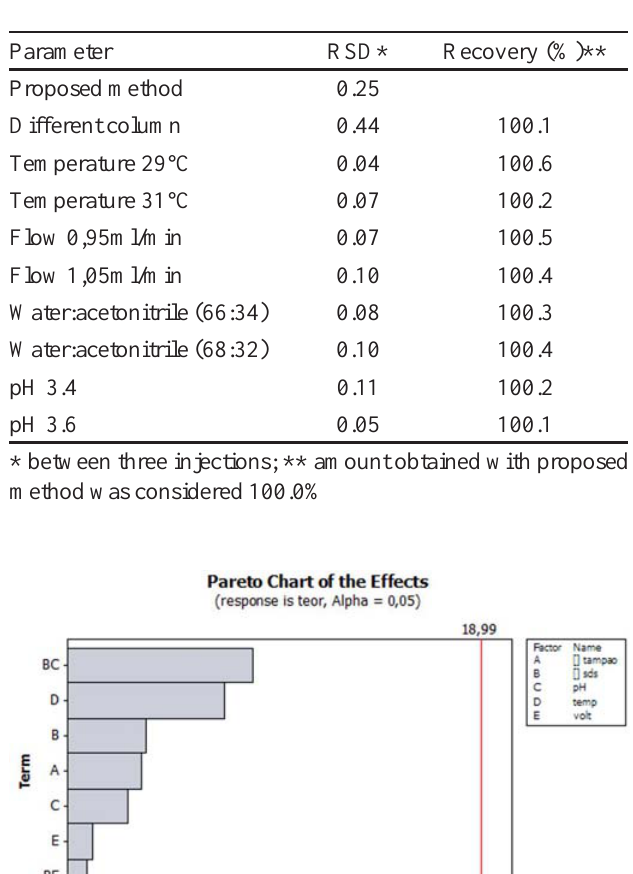
TABLE IV - Robustness of HPLC method